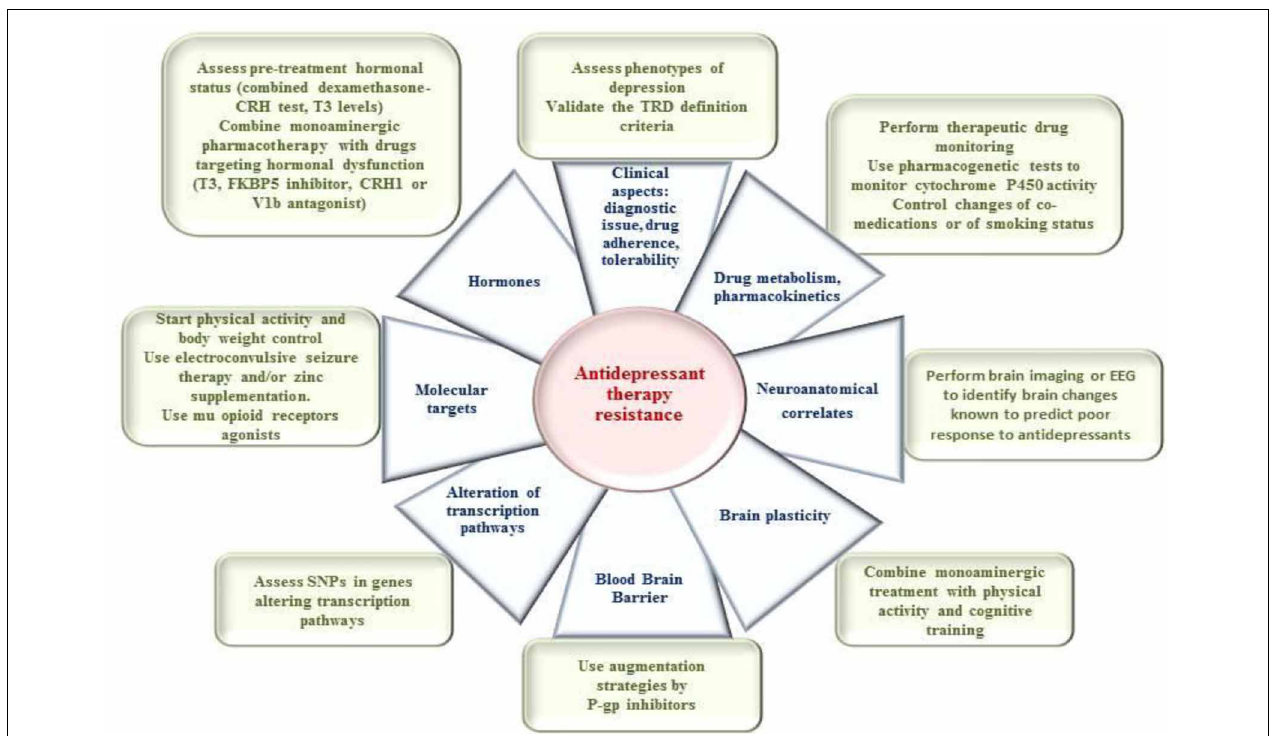
FIGURE 1 | Mechanisms (in blue) associated with antidepressant therapy resistance and recommendations for clinical practice (in